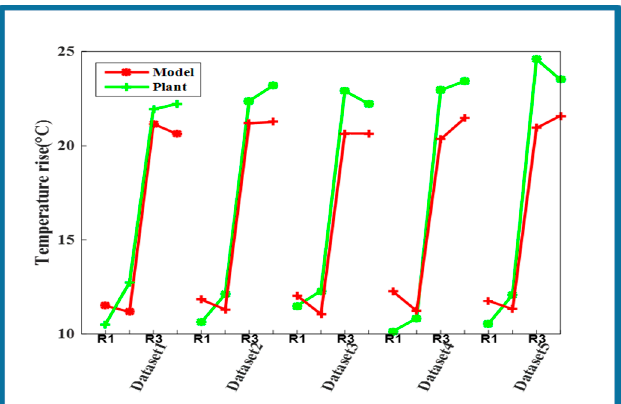
Figure 13. Predictions of temperature rise of the HT reactor for the residue hydrorefining process.